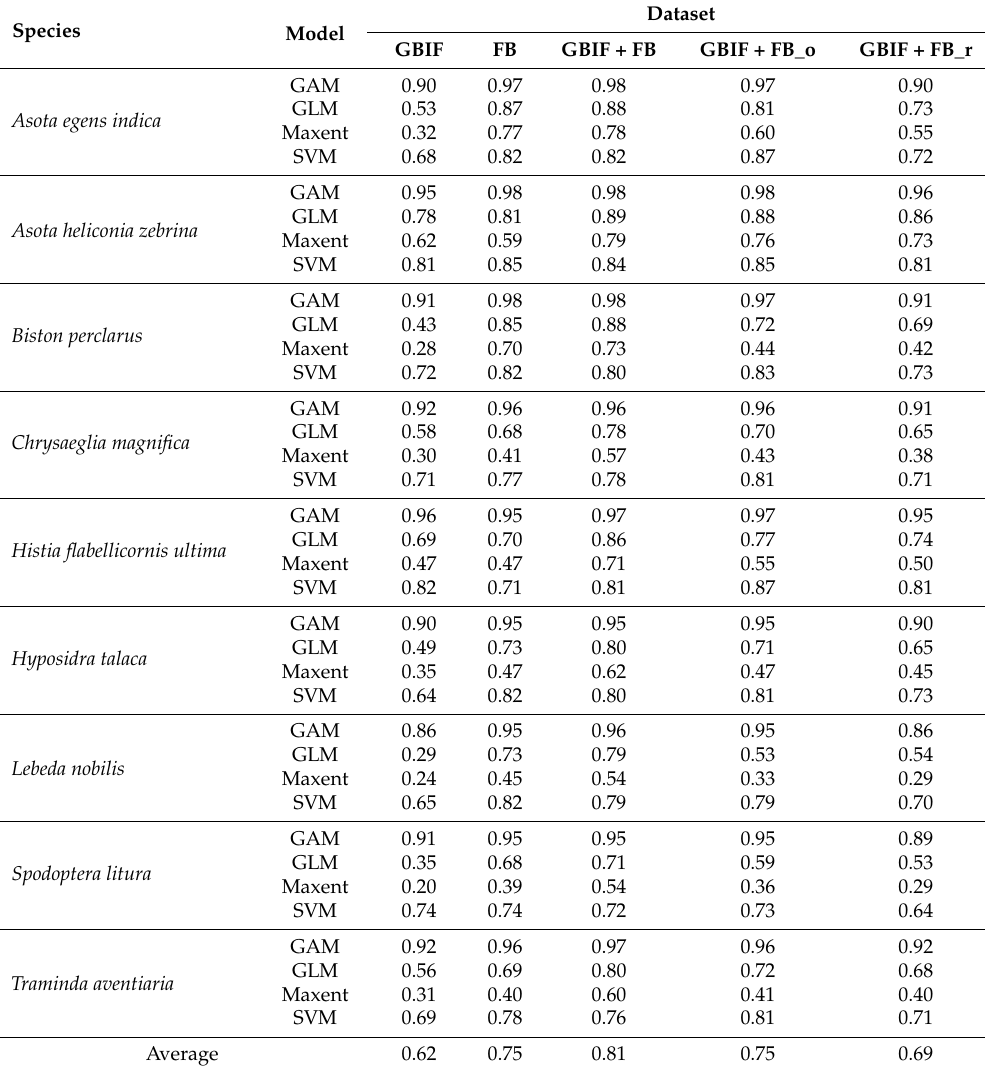
Table 5. Explained variation by the first PCA component of the 1000 species distributions derived from four SDMs based on five datasets under a 0.5 cooling